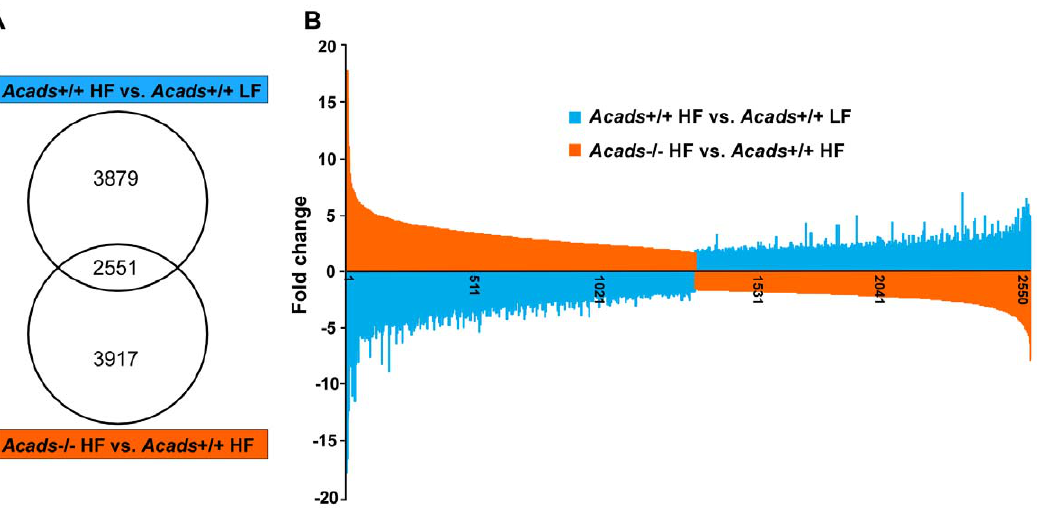
Figure 3. Transcriptional responses of Acads 2 / 2 mice fed HF diet are similar to those of Acads + / + mice fed LF diet. A: Comparison of statistically significant responses from HF Acads 2 / 2 vs. HF Acads + / + (genotype effects) and from HF Acads + / + vs. LF Acads + / + mice (diet effects) revealed that 2551 genes or approximately 65% were differentially expressed in both experimental comparisons (X-axis). B: All but one of the 2551 genes were expressed in opposite direction, as indicated (blue vs. tan color), and with similar magnitude of change (Y-axis).